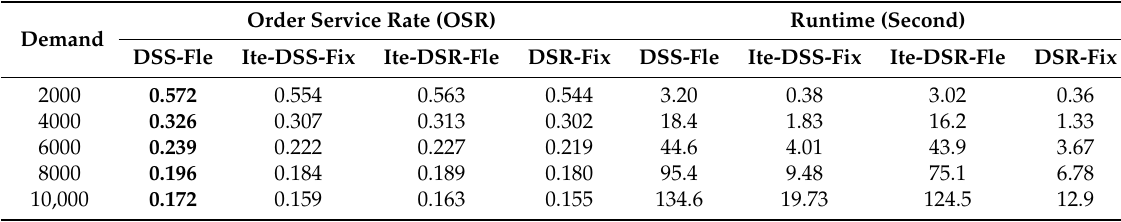
Table 3. Order Service Rate (OSR) and running time on large-scale instances. To make the table clear, we omit the statistical errors, and each cell is statistically significant at a 95% confidence